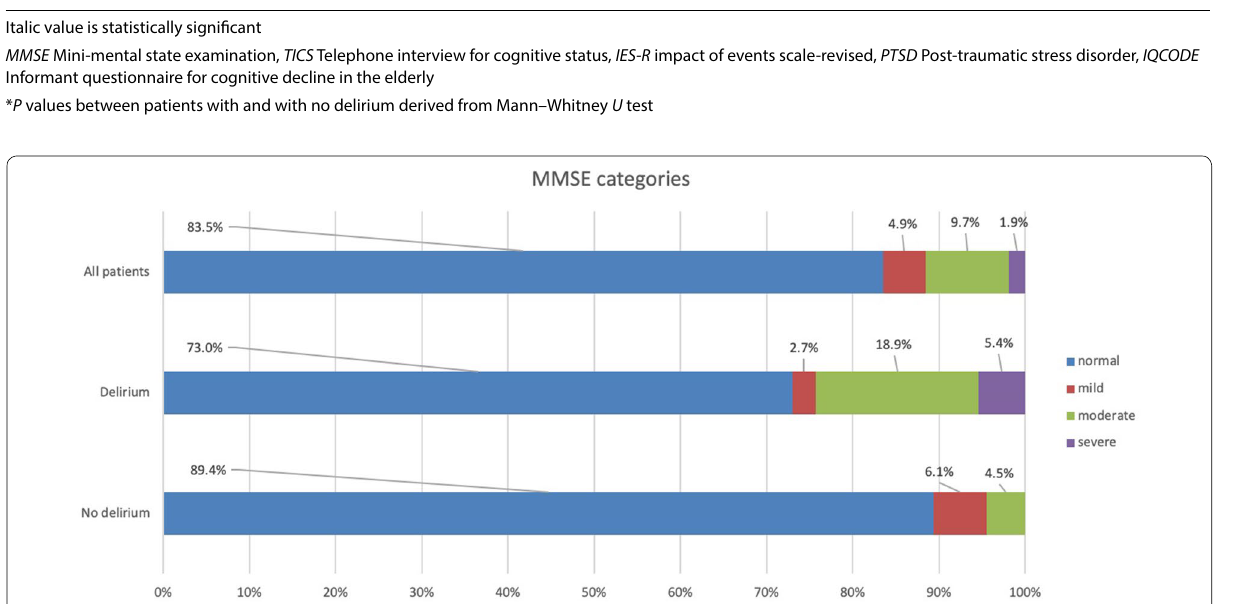
Italic value is statistically significant